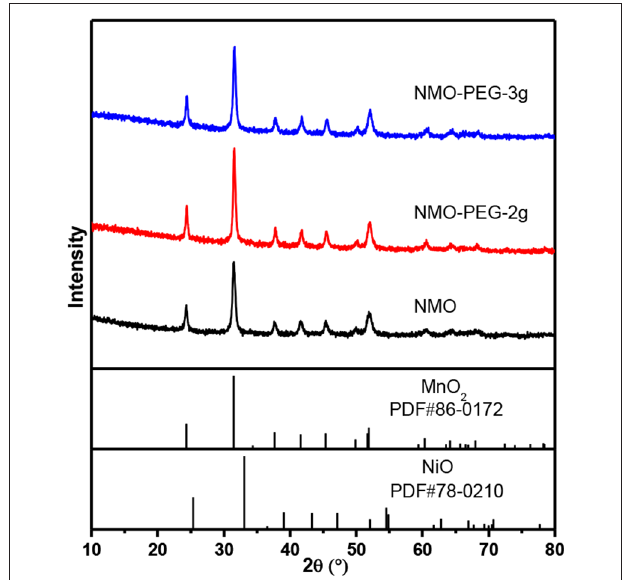
FIGURE 2 | XRD patterns of NiMnO